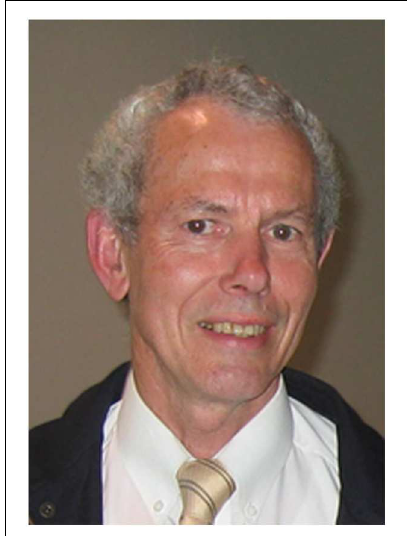
FIGURE 1 | Neil McKern in 2006